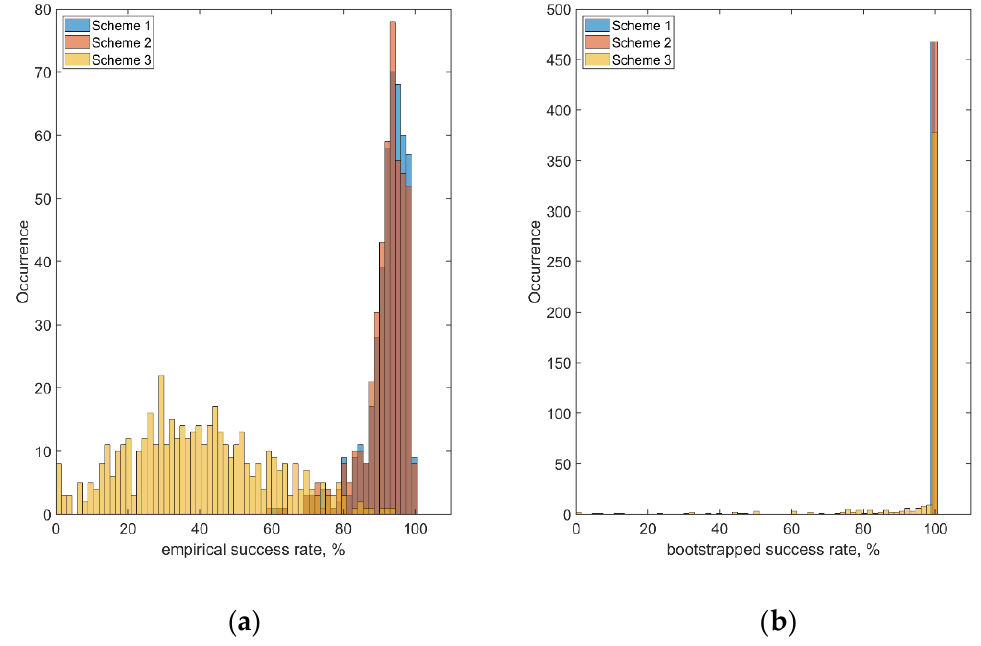
Figure 6. Distribution of the ambiguity resolution success rates for the three empirical ( a ) and bootstrapped ( b ) processing schemes.